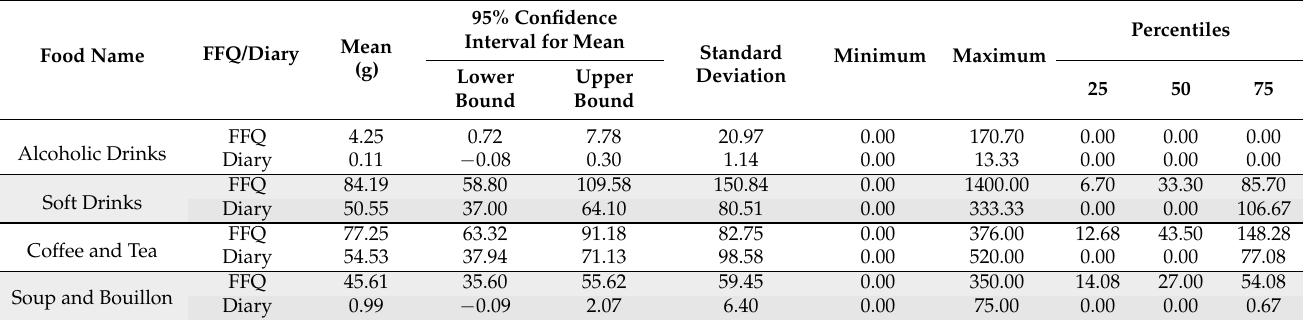
Table A4. Descriptive of the total study population (mean ± standard deviation; Min. P25. P50. P75 and Max; 95% confidence interval). Descriptive youngest group (12–13 years); n =